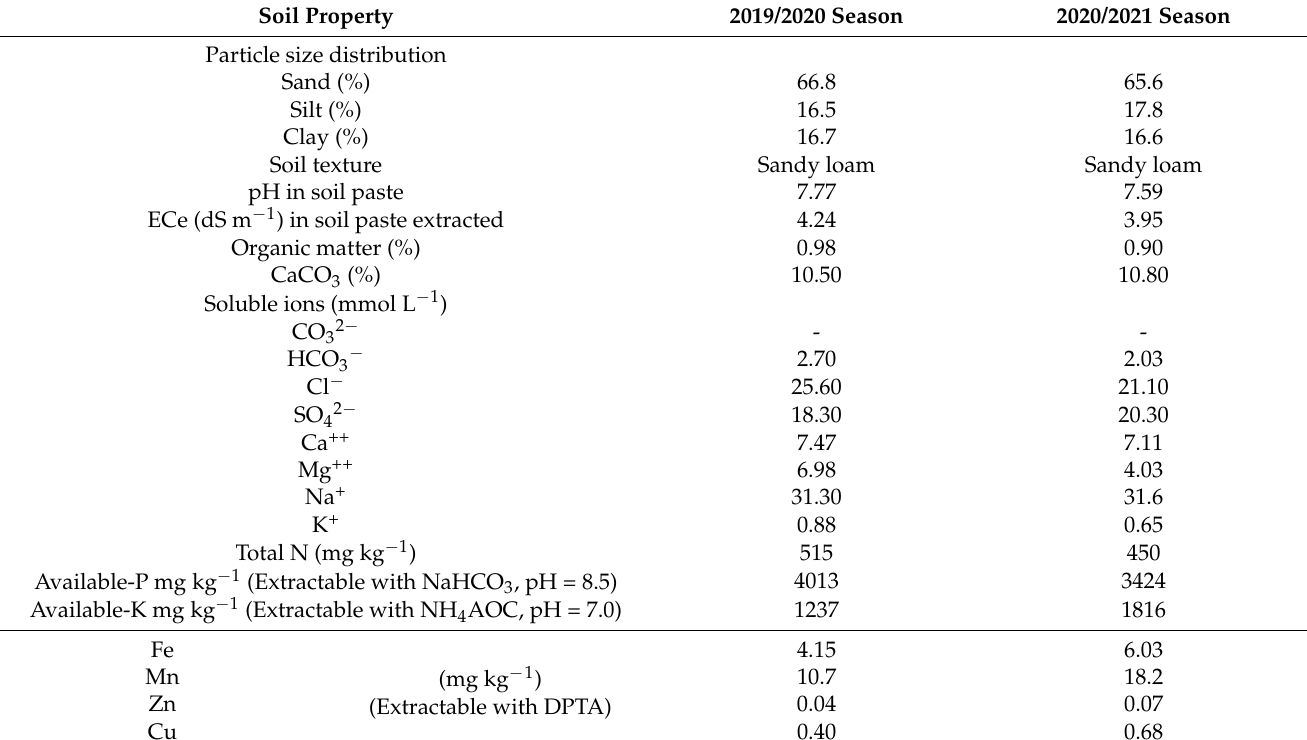
Table 2. Some soil physical and chemical characteristics of the experimental farm. Soil